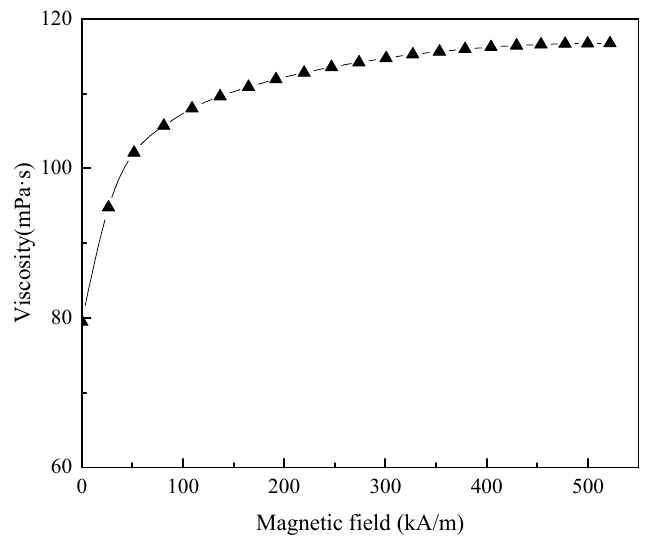
Figure 4. Relationship between the viscosity of the magnetic fluid and the magnetic field strength. Based on the results of Figures 3 and 4, it is clear that the viscosity of the magnetic fluid achieved magnetic saturation and the ultimate shear state under high-speed sealing conditions, due to the sufficiently strong magnetic field and high shear rate. Therefore, the temperature is the key factor affecting the variation in viscosity under high-speed sealing conditions, ignoring the influence of the magnetic field and the shear rate. The viscosity–temperature curve of diester-based magnetic fluids was experimentally measured at a magnetic field strength of 400 kA/m and a shear rate of 1000 s − 1 . As depicted in Figure 5, viscosity gradually decreases with an increase in temperature, showing a nonlinear relationship, and the decrement becomes slower at higher temperatures.